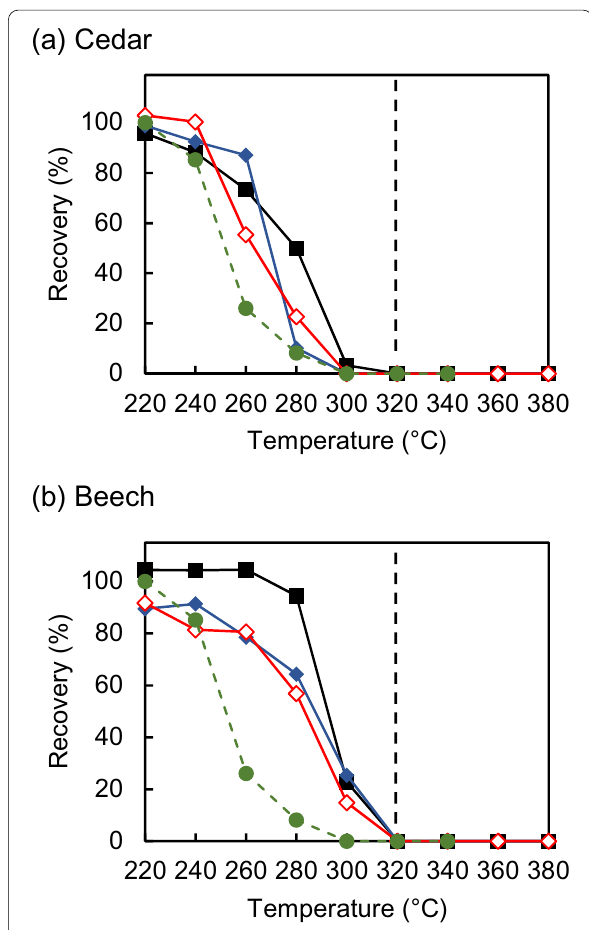
Fig. 10 Recovery rate of 4- O -MeGlcA as a methanolysis product after the pyrolysis of ball-milled a cedar and b beech wood for 10 min ( ) and 4 h ( ), compared with unmilled wood ( ) and isolated hemicellulose (